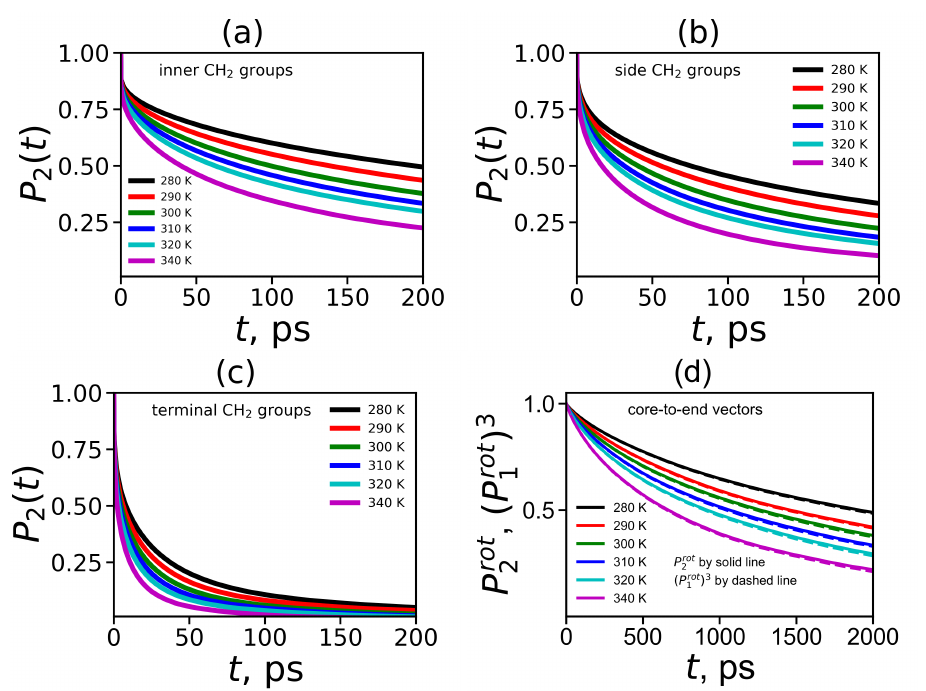
Figure 9. The time dependencies of ACF P 2 ( t ) for ( a ) inner, ( b ) side, ( c ) terminal CH 2 groups. ( t ) and (cid:0) P rot ( t ) (cid:1) 3 for the core-to-end vectors. All data are ( d ) The time dependencies of ACFs P rot 2 1 presented for the Lys-2Arg dendrimer at the temperature range from 280 to 340